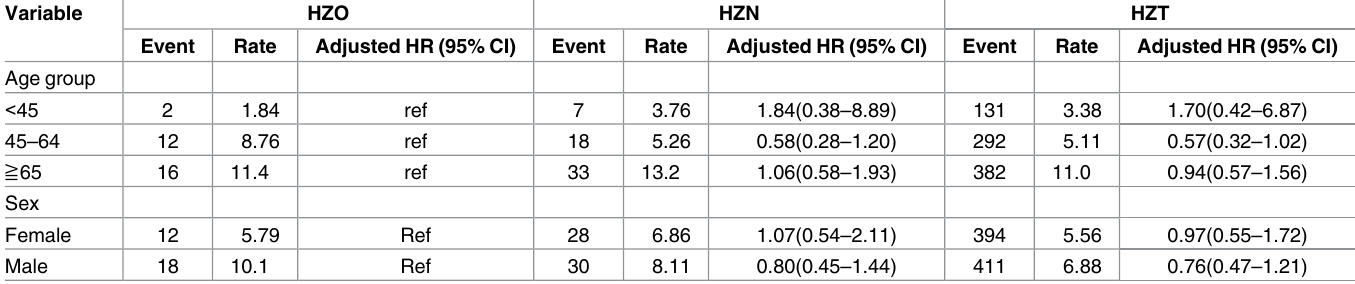
outcomes in the HZN and HZT cohorts was not significantly different compared with that in the HZO cohort after stratification by age and sex. Table 4 lists the ocular risk in the study cohorts stratified by age and sex. Compared with the HRs in the HZN cohort, those for ocular complications were 0.54 (95% CI = 0.30–0.99) for female patients and 0.40 (95% CI = 0.24– 0.68) for male patients in the HZT cohort. Except for patients in the (cid:21) 65-year age group, those in all other age groups in the HZT cohort exhibited a significantly lower risk of ocular compli- cations than did those in the < 45-year (HR = 0.20, 95% CI = 0.09–0.43) and 45–64-year (HR = 0.37, 95% CI = 0.20–0.69) age groups in the HZN cohort. Table 5 presents the risk of neurological complications in the HZO and HZT cohorts stratified by age and sex. The risk of neurological complications was significantly lower in the HZT cohort than in the HZO cohort only for patients aged 45–64 years (HR = 0.55, 95% CI = 0.38–0.80) and male patients (HR = 0.62, 95% CI = 0.46–0.82). Table 6 presents the PTN outcomes for all HZ cohorts. Compared with the risk of PTN in the HZO cohort, that in the HZN and HZT cohorts stratified by age Table 3. Risk of herpes zoster complications (cutaneous) in types of herpes zoster stratified by age and sex. Adjusted HR: Adjusted for age, sex, CAD, hypertension, hyperlipidemia, DM, stroke, AF, renal disease, heart failure, cancer, chronic hepatitis, and SLE. Rate: incidencerate per 1000 person-